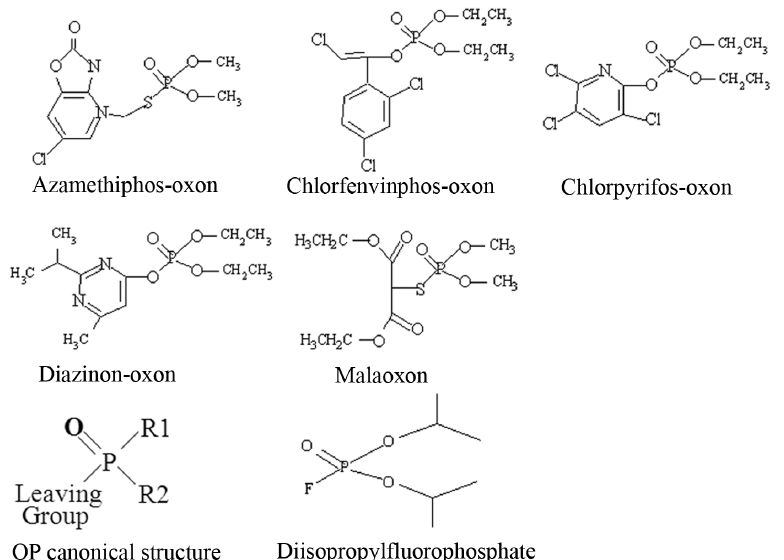
Figure 1. Structures of pesticides employed for in vitro